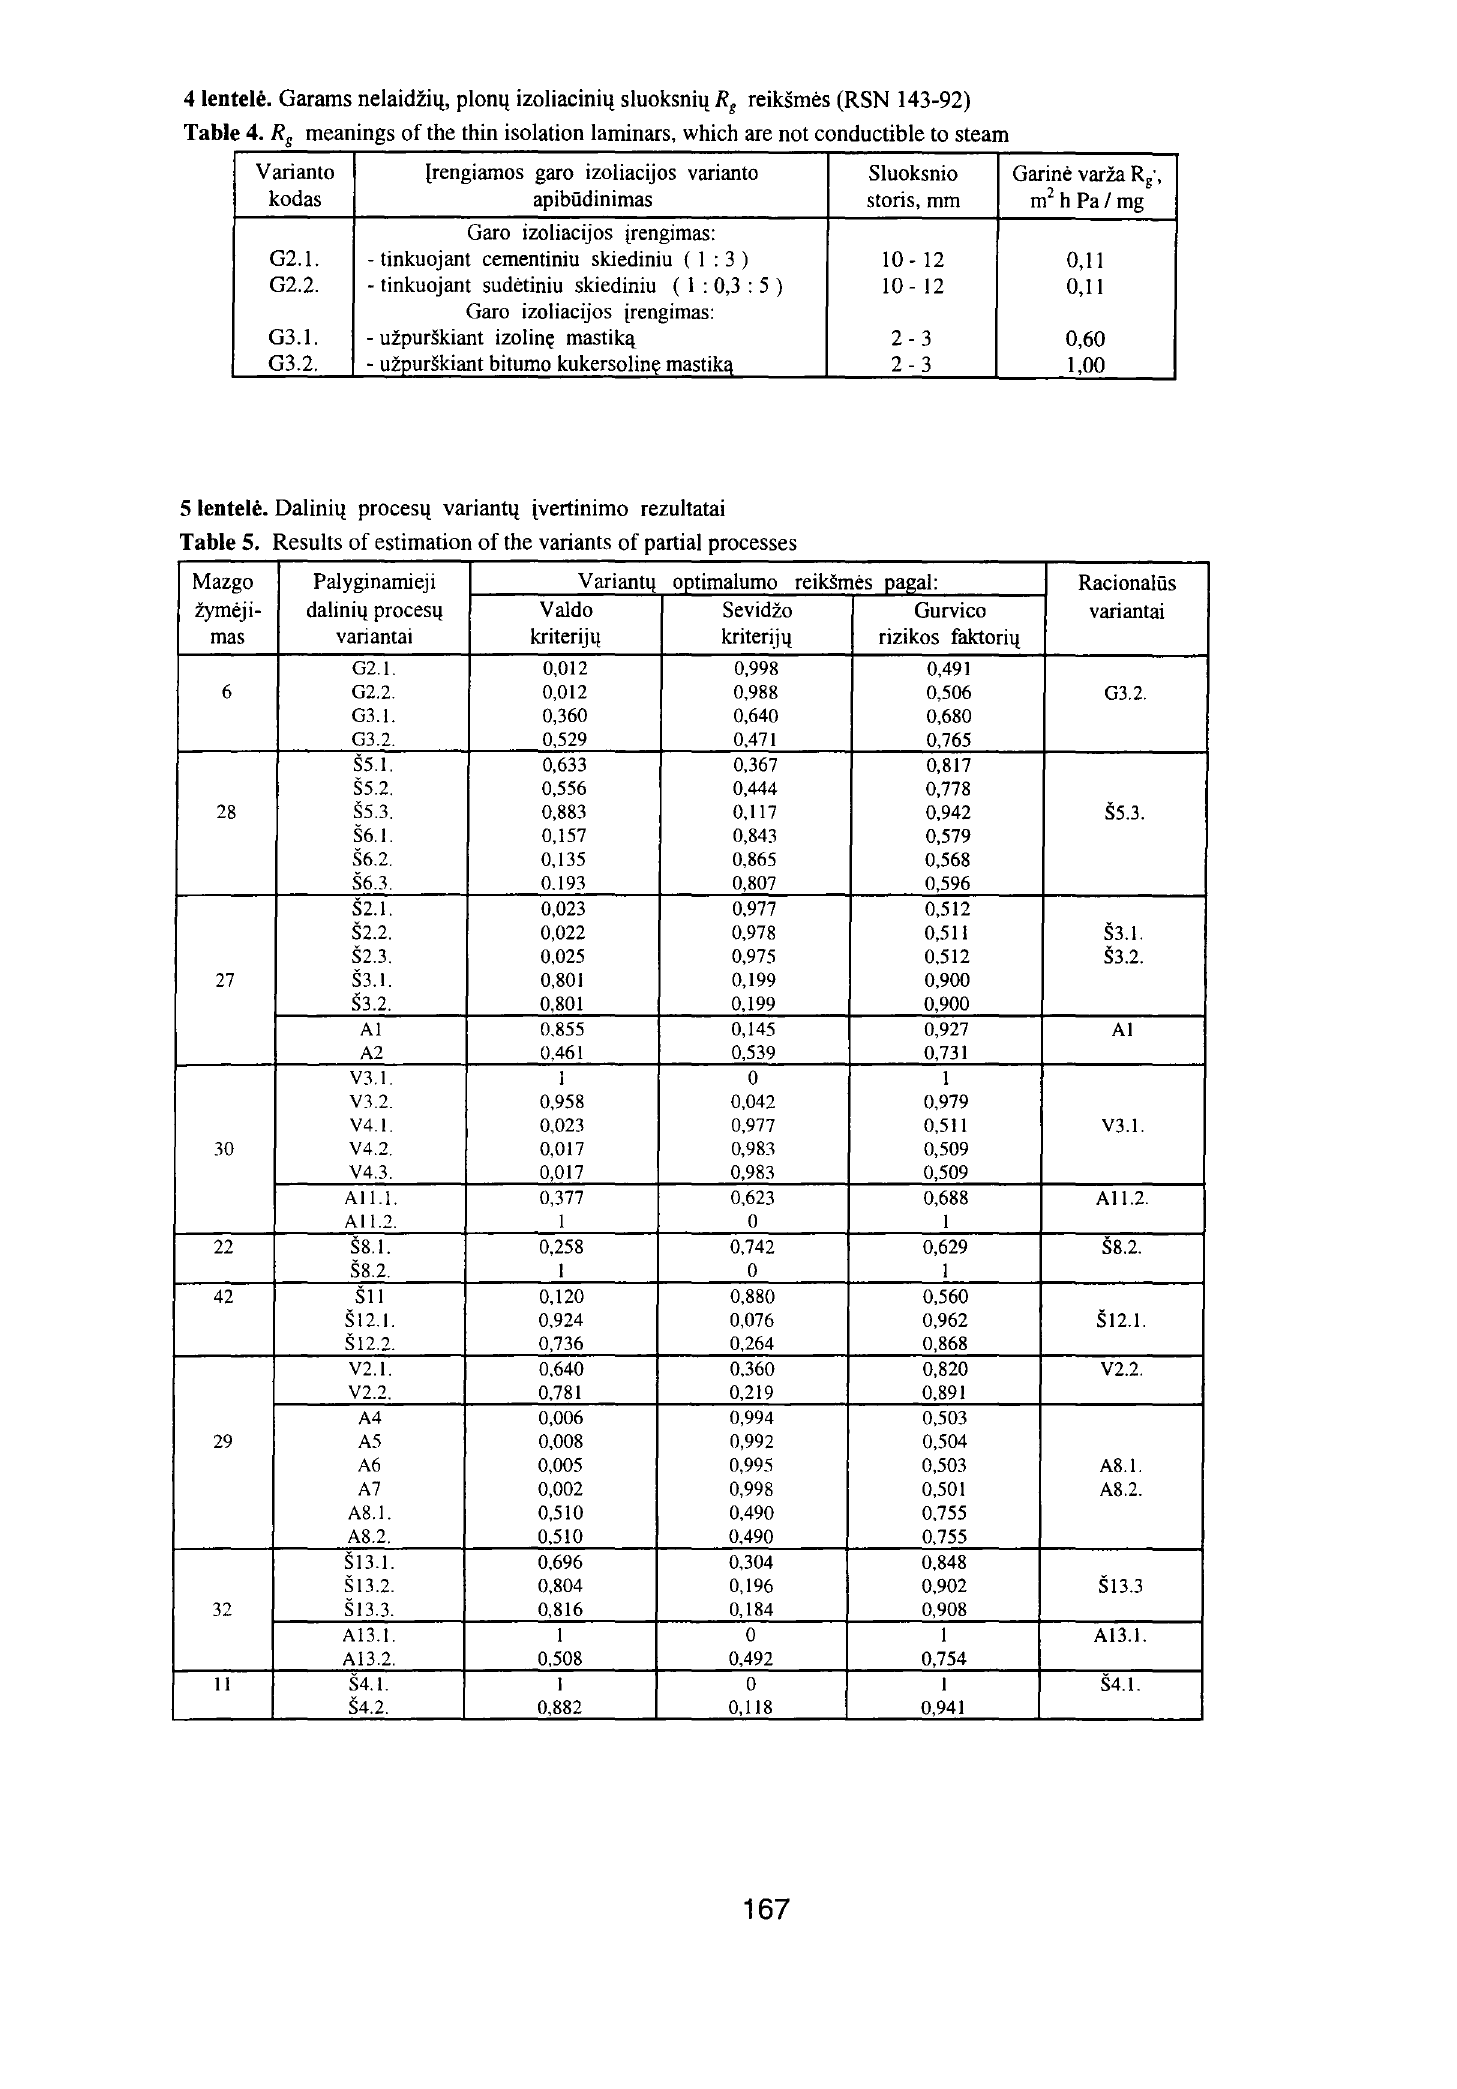
Table 5. Results of estimation of the variants of partial